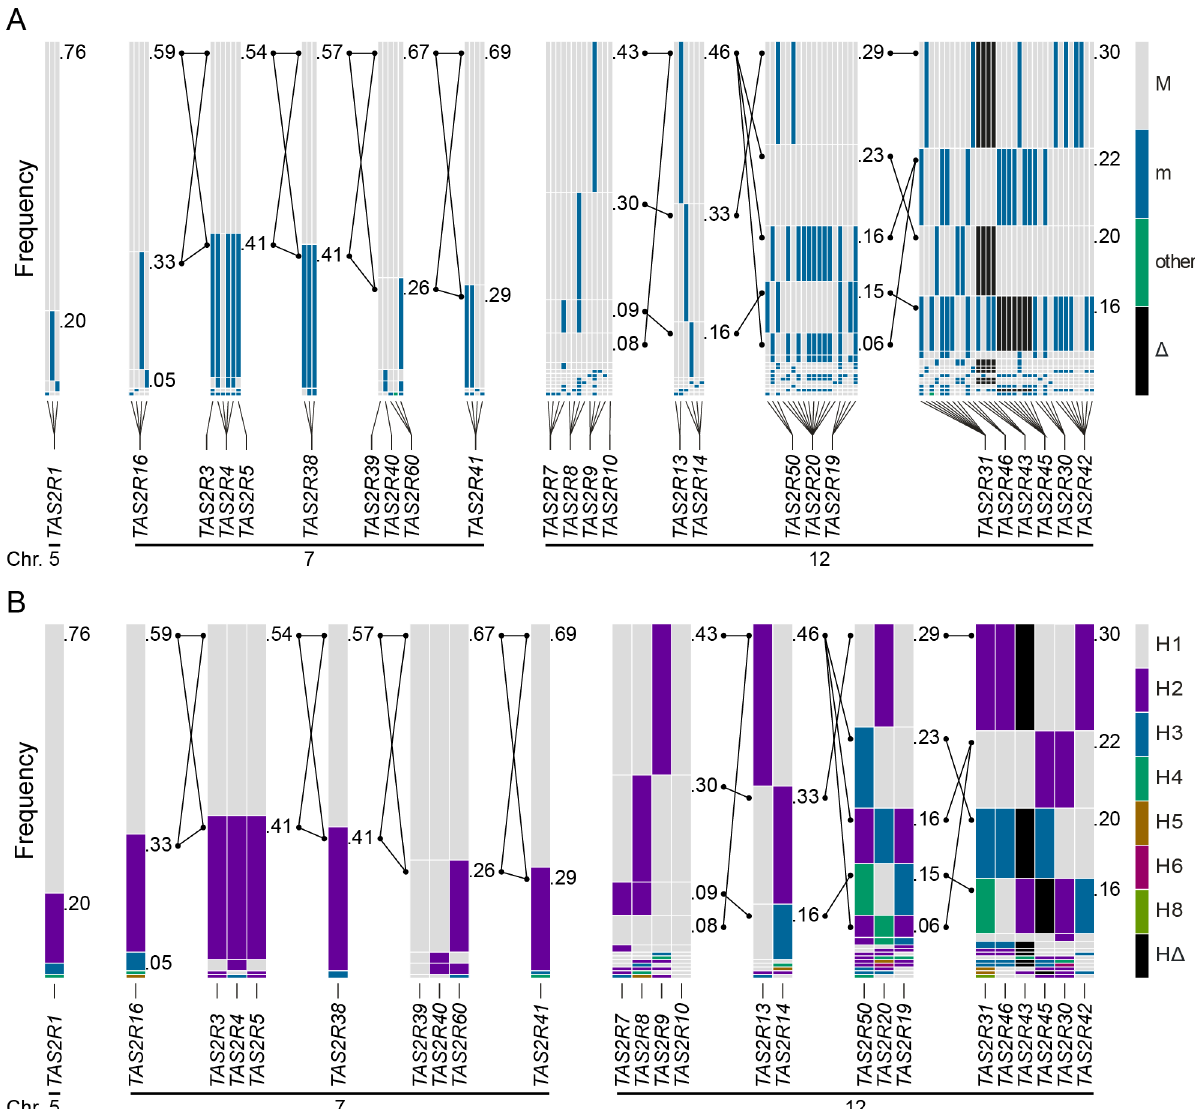
Fig 5. Haplotype block structure, common haplotype and long-range haplotype (LRH) across the TAS2R genes regions on chromosome 5, 7, and 12 parsed using (A) cSNPs and (B) TAS2R genes. Long-range multilocus haplotypes were phased for the TAS2R3-5 and the TAS2R39-60 regions on chromosome 7; and the TAS2R7-10 , the TAS2R13-14 , the TAS2R50-19 , and the TAS2R31-42 regions on chromosome 12. They are displayed with their corresponding frequency and connected TAS2R haplotypes with lines if the minor frequency is greater than 0.05. For the TAS2R3-5 and the TAS2R39-60 blocks, two common long-rang haplotypes with a frequency of more than or equal to 0.05 were inferred. The TAS2R7-10 , the TAS2R13-14 , the TAS2R50-19 , and the TAS2R31-42 harbour 4, 3, 5, and 4 long-range haplotypes,